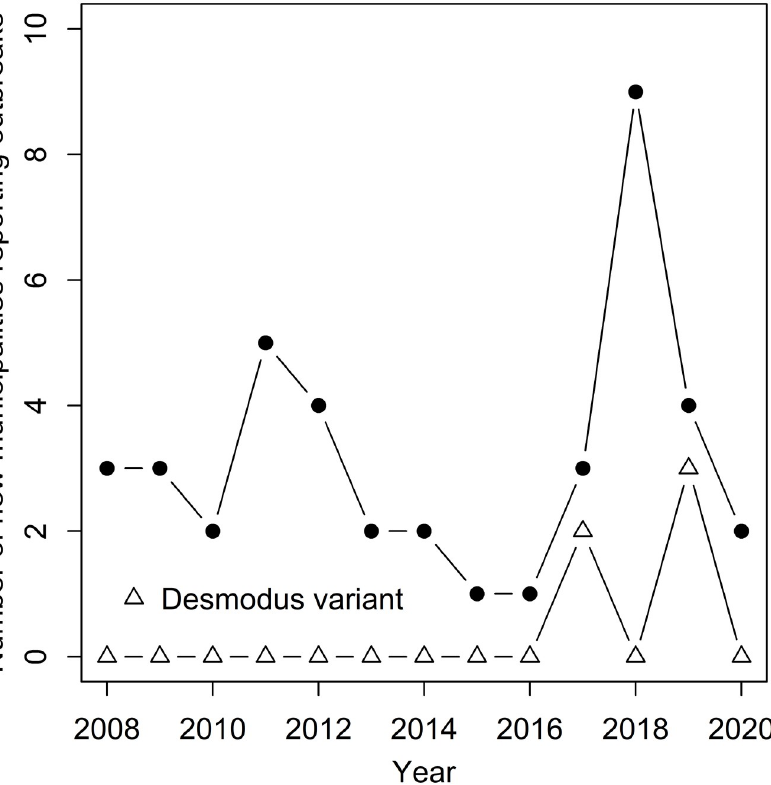
Fig 3. Geographical expansion of rabies reported in Callithrix jacchus . Number of municipalities reporting outbreaks for the first time each year from 2008 to October 2020. Open triangles show outbreaks belonging to the Desmodus rotundus variant